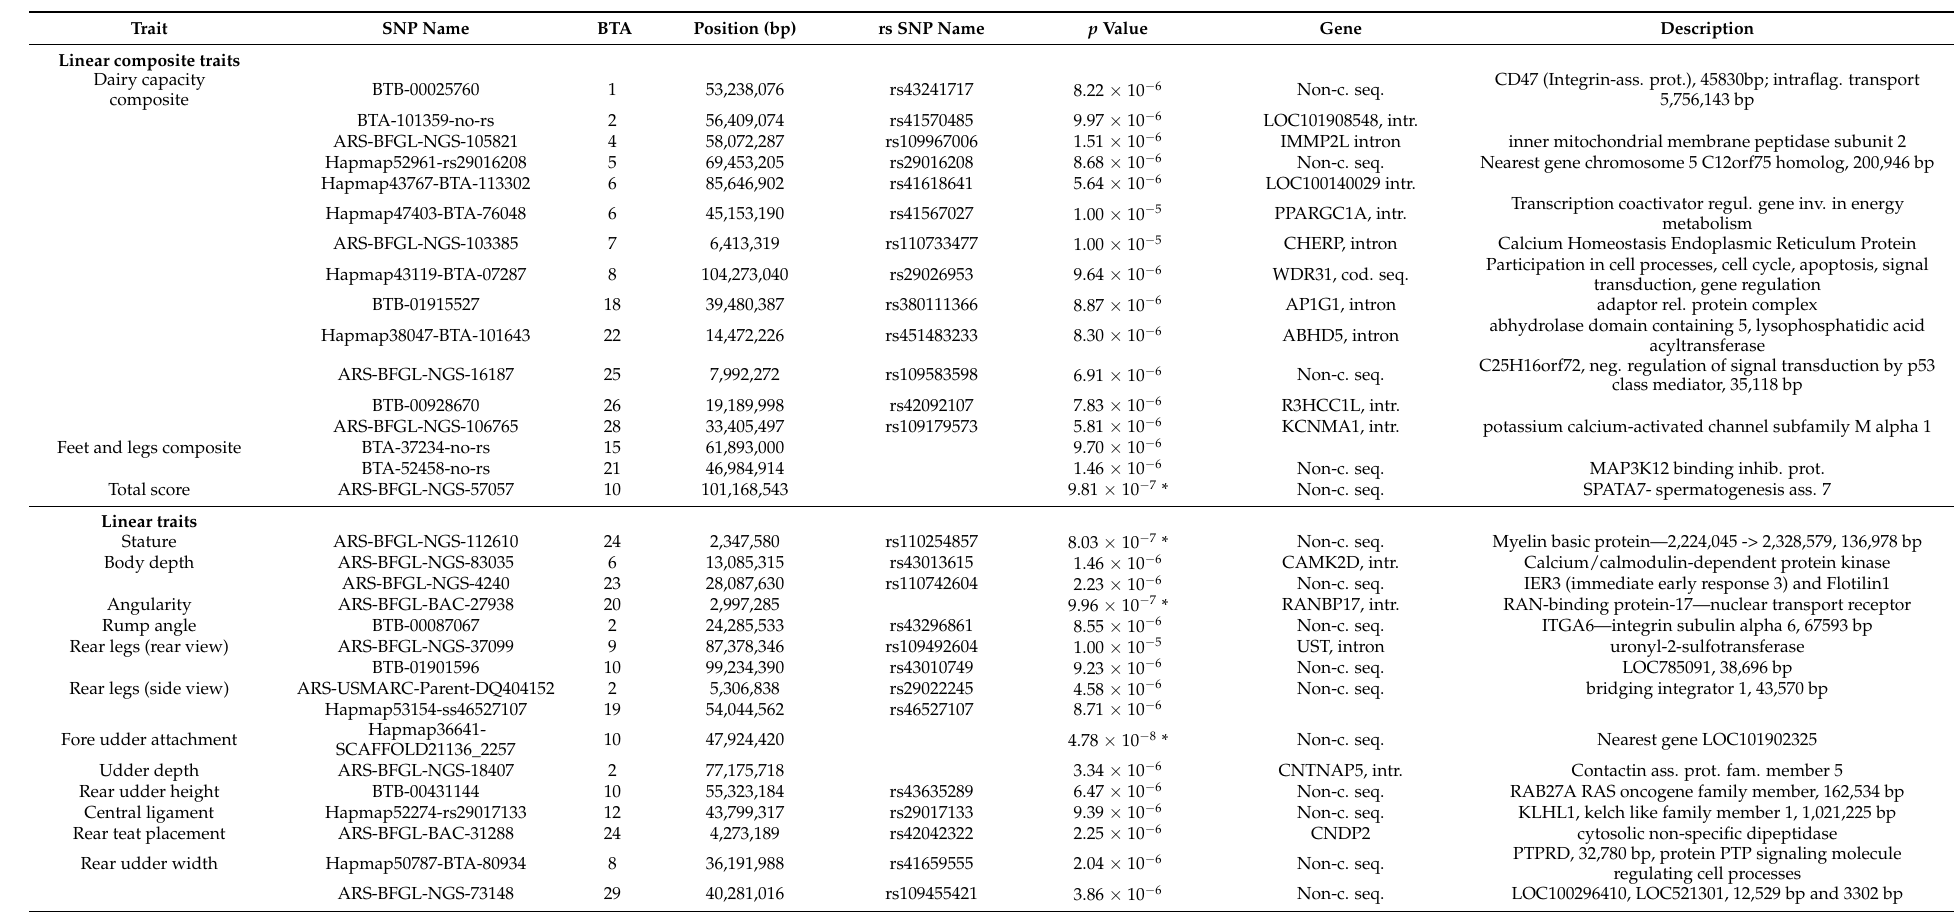
Table 4. The SNP markers with statistically significant (or approaching the significance threshold) associations with linear traits without the Bonferroni correction.